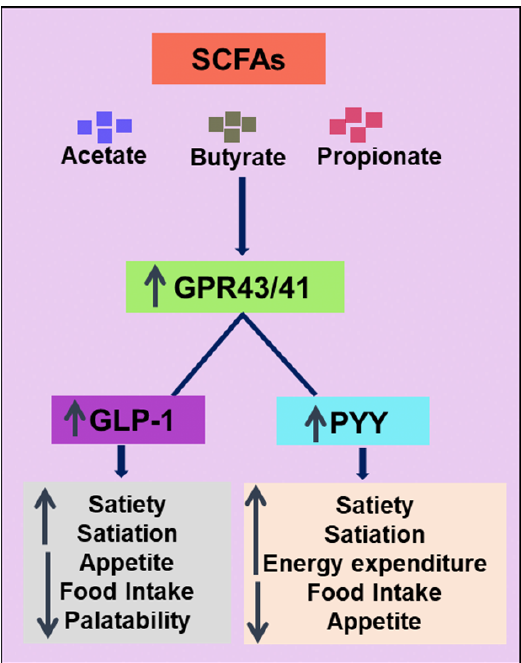
Figure 3. Anti-obesity effect of short-chain fatty acids (SCFAs). SCFAs activate G-protein-coupled receptors GPR-43 and GPR-41 that increase secretion of hormones, including glucagon-like peptide-1 (GLP-1) and peptide YY (PYY), manifesting anti-obesity effects. ↓ = Decrease, ↑ = Increase.